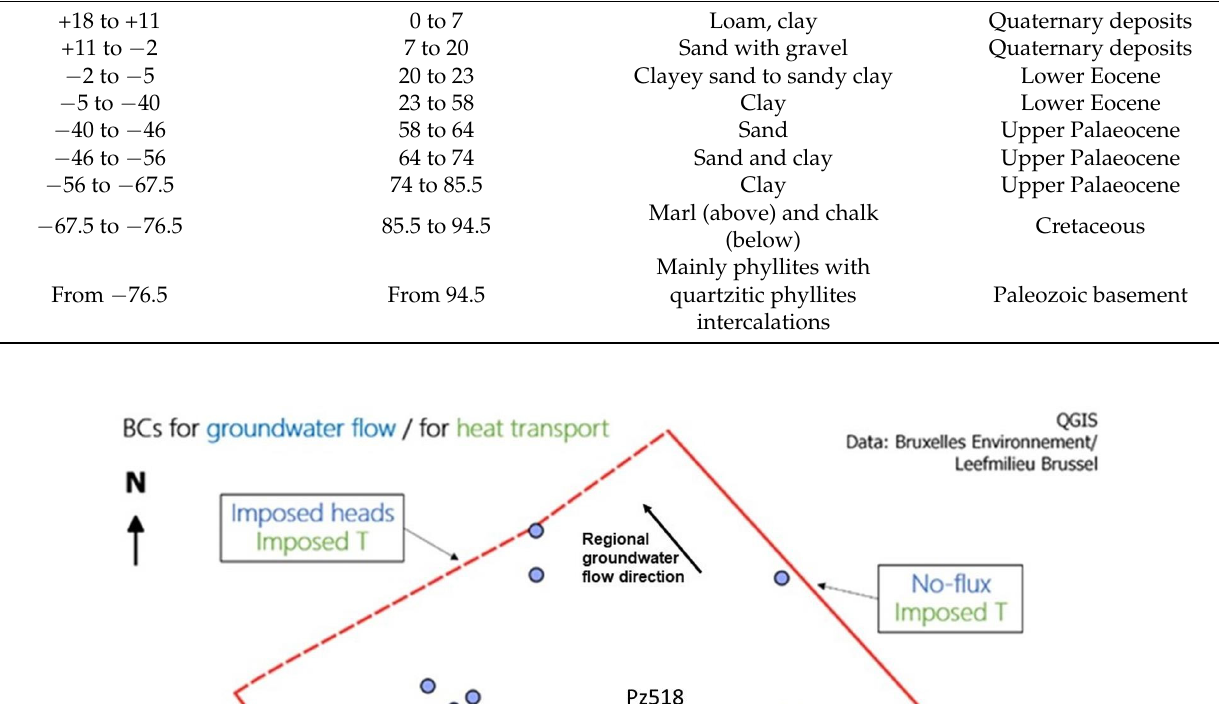
Table 1. Geology as observed during drilling at the location of Building n ◦ 1.